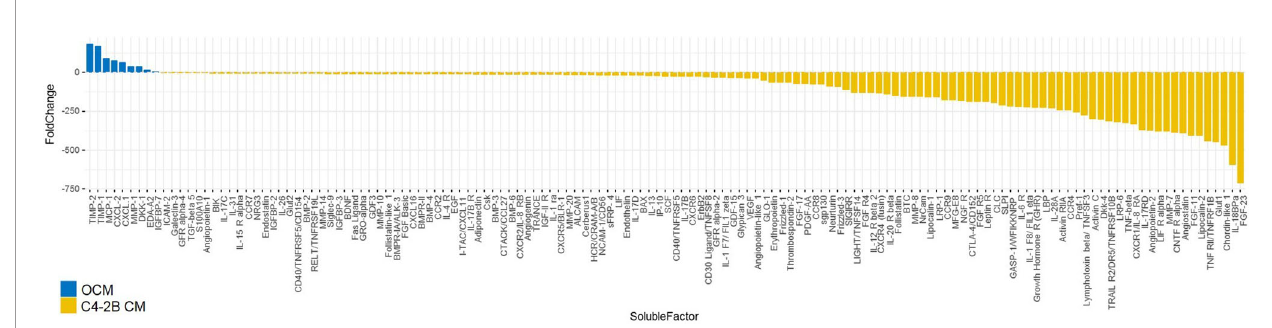
FIGURE 6 | Waterfall plot of soluble molecules differentially expressed in OCM compared to C4-2B CM (expressed as fold change). Proteomic analysis was performed on OCM pooled from three different donors and C4-2B CM from three different cell passages; molecules overexpressed in OCM with a fold change > 2 (blue) and downregulated fold change < 2 (yellow) are reported.